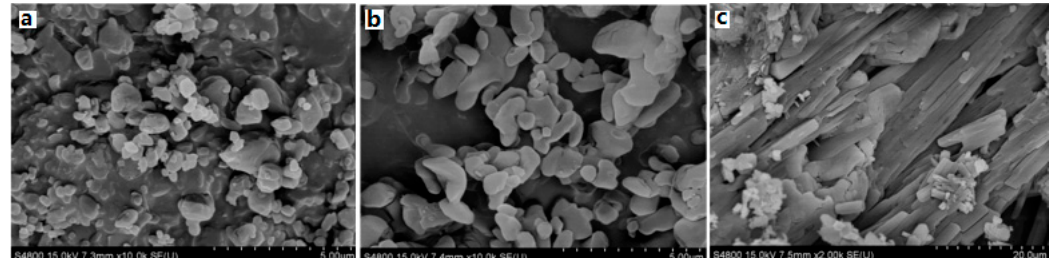
Figure 13. SEM photographs of CL-20, TKX-50 and CL-20/TKX-50 cocrystal. ( a ) raw CL-20; ( b ) Raw TKX-50; ( c ) CL-20/TKX-50 cocrystal [34], with permission from Huo Zha Yao Xue Bao, 2020.